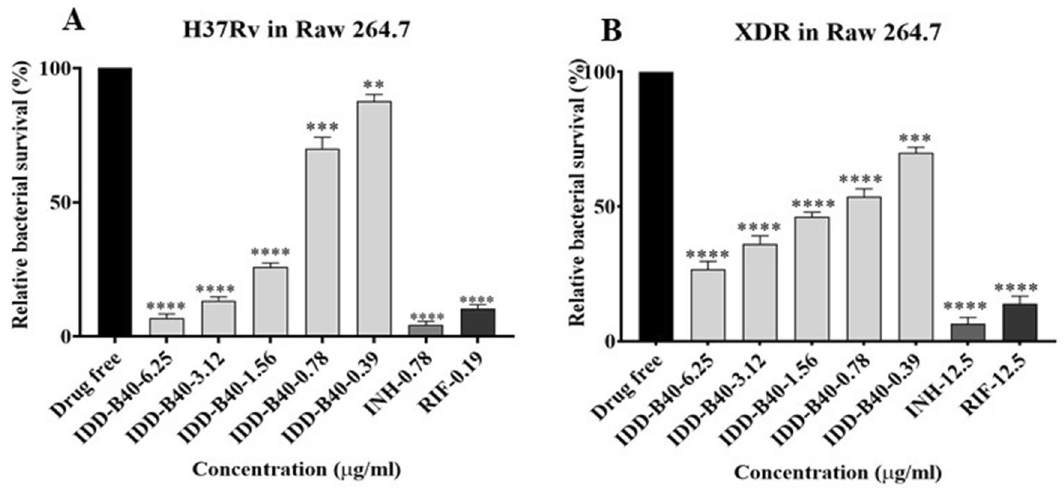
Figure 5. Intracellular killing effect of IDD-B40, isoniazid (INH) and rifampicin (RIF) in M. tuberculosis - infected macrophages (Raw 264.7). ( A ) Relative survival of H37Rv in H37Rv-infected macrophages after IDD-B40, INH, and RIF treatment. ( B ) Relative survival of XDR-TB in XDR-TB-infected cells after IDD-B40, INH, and RIF treatment. Data represent the mean ± SD of three independent experiments done in triplicate. *** p < 0.001, **** p < 0.0001 by Student’s t